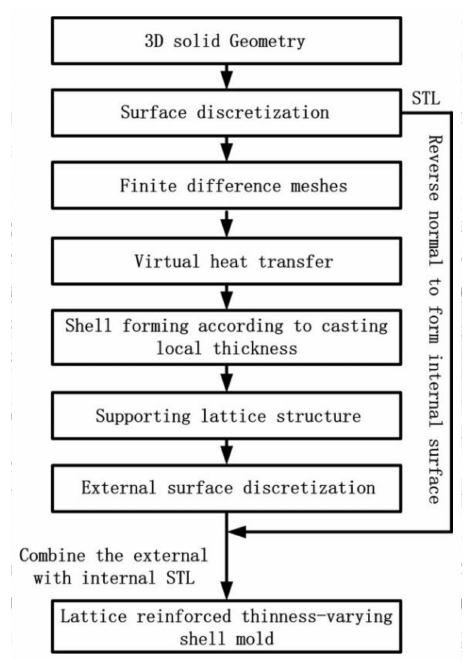
Figure 1. The process for generating the lattice-reinforced thickness-varying shell